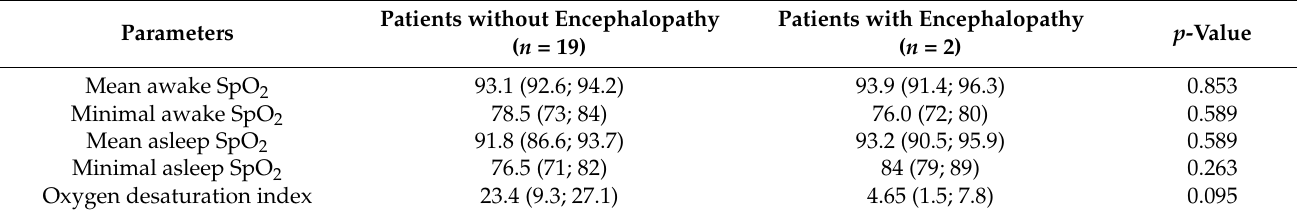
Table 3. The parameters of pulse oximetry in the patients with and without encephalopathy.